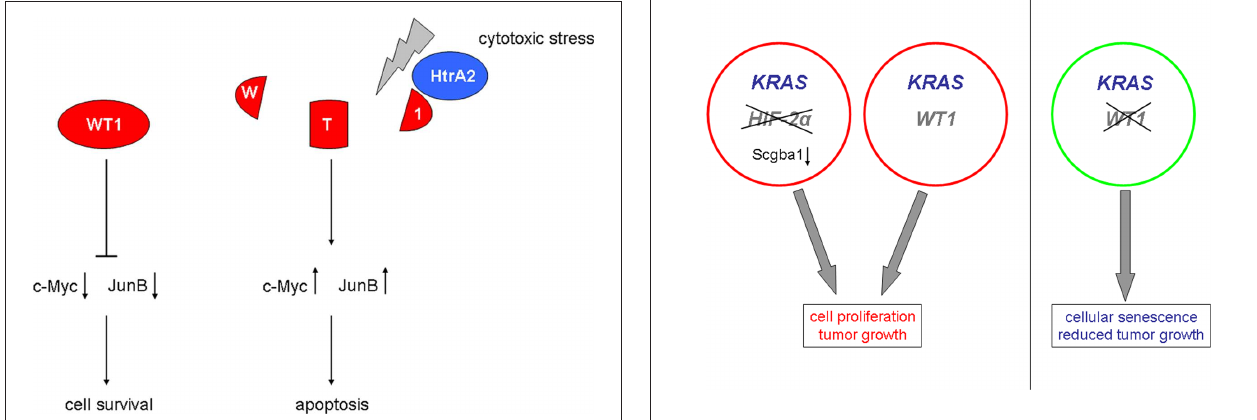
FIgure 3 | role of the mitochondrial serine protease HtrA2 in the regulation of WT1 function. Activation of HtrA2 by cytotoxic stress causes degradation of WT1 protein, thereby increasing the proapoptotic transcription factors c-Myc and